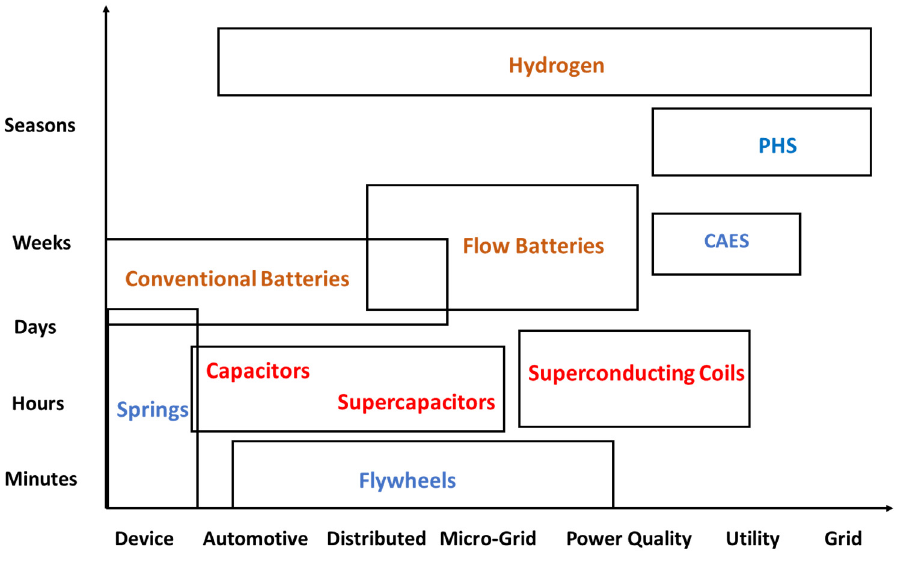
Figure 12 . Applications and timescales of ES systems . Figure 12. Applications and timescales of ES